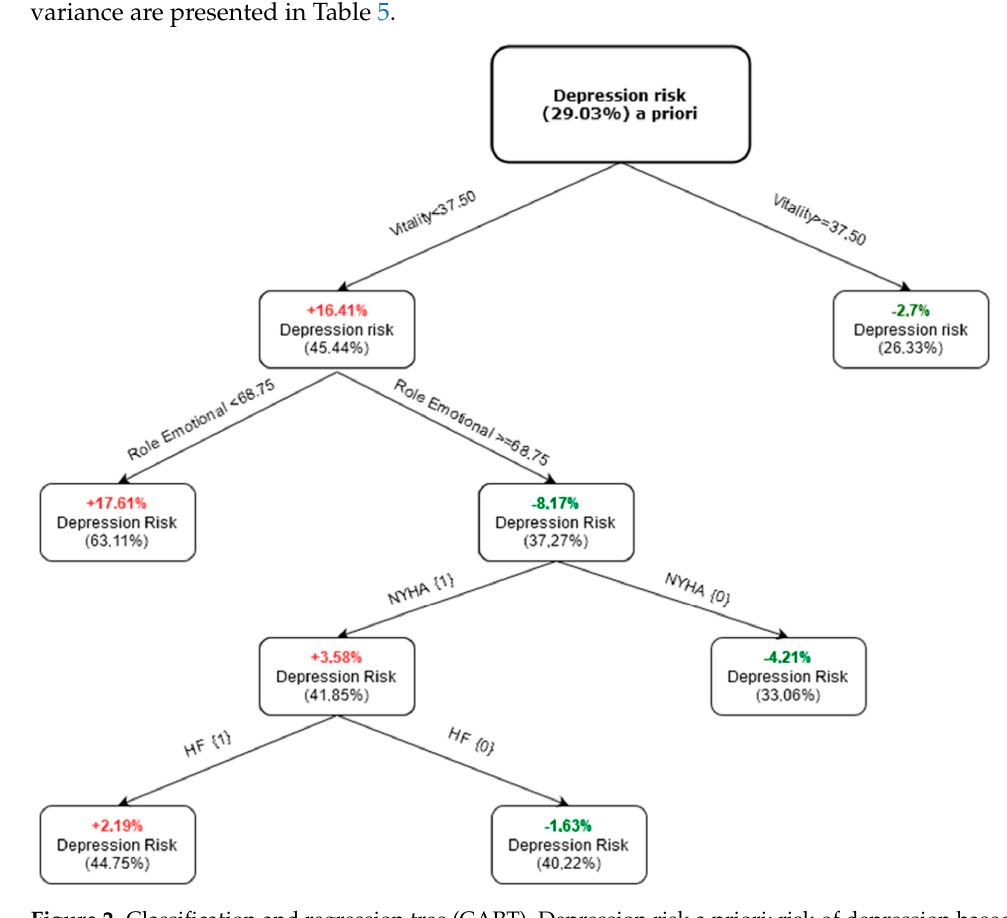
Figure 2. Classification and regression tree (CART). Depression risk a priori; risk of depression based on MCS score. NYHA; New York Heart Association classification of heart failure. HF; heart